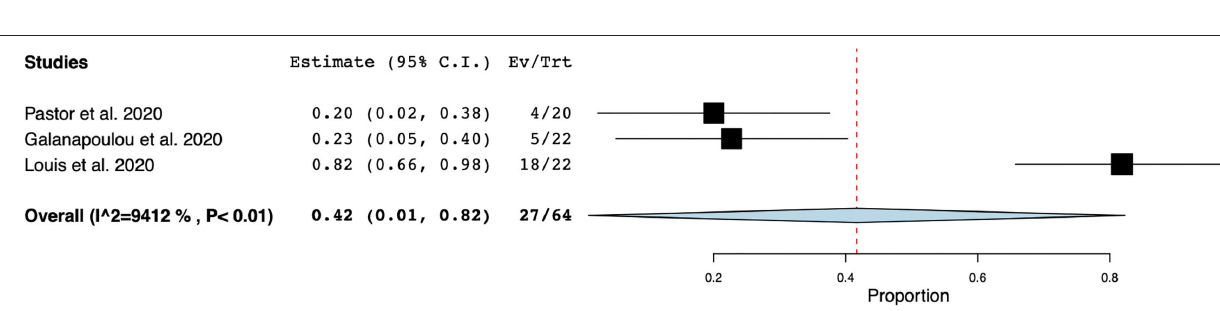
FIGURE 3 | Forest plot of periodic and rhythmic patterns (RPPs) in non-ICU patients. RPPs was found in 27/64 patients with a pooled prevalence of 0.42 (95% Confidence Interval (CI) 0.01–0.82, SE 0.21, p < 0.04), τ 2 0.12, Q (df = 2) 34.02, p < 0.01, I 2 =